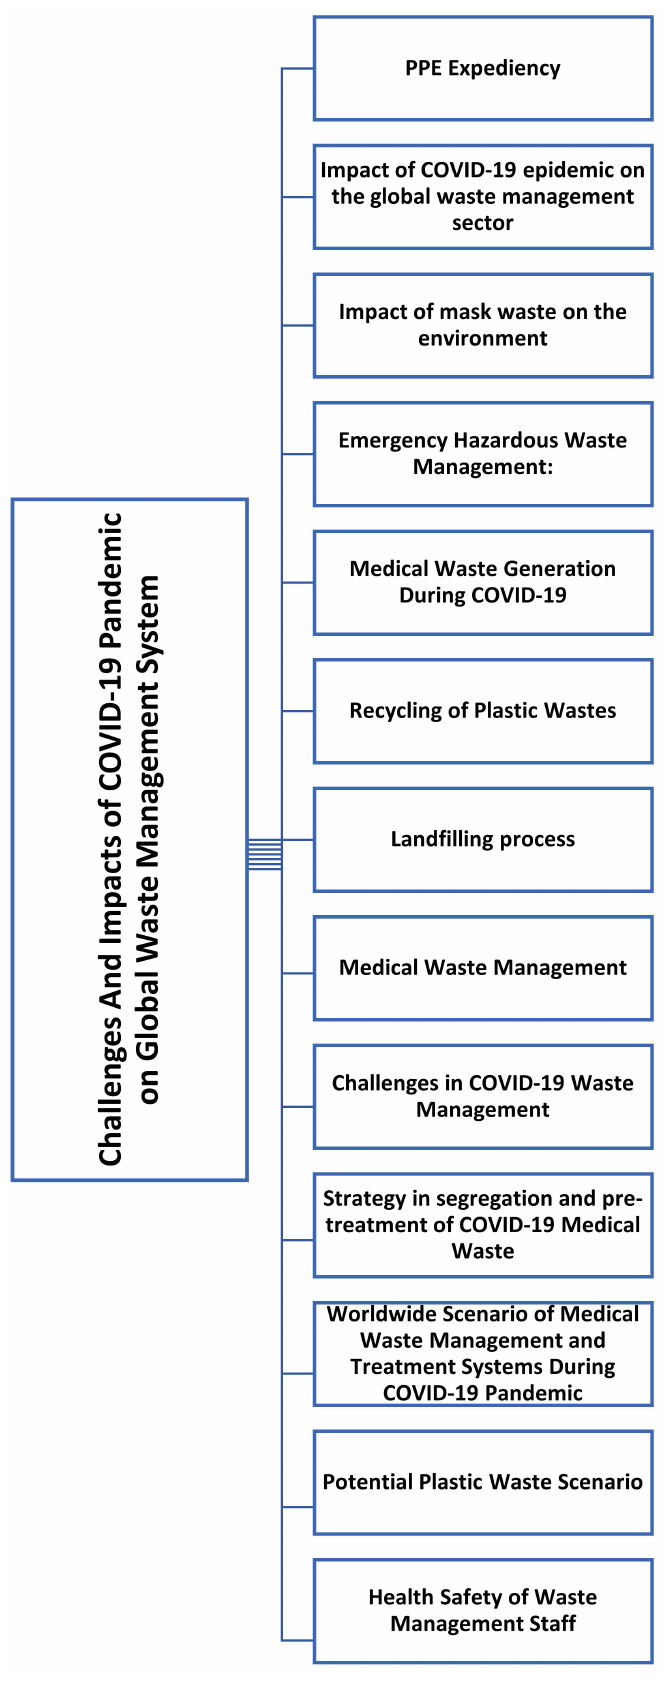
Figure 2. Structure of the